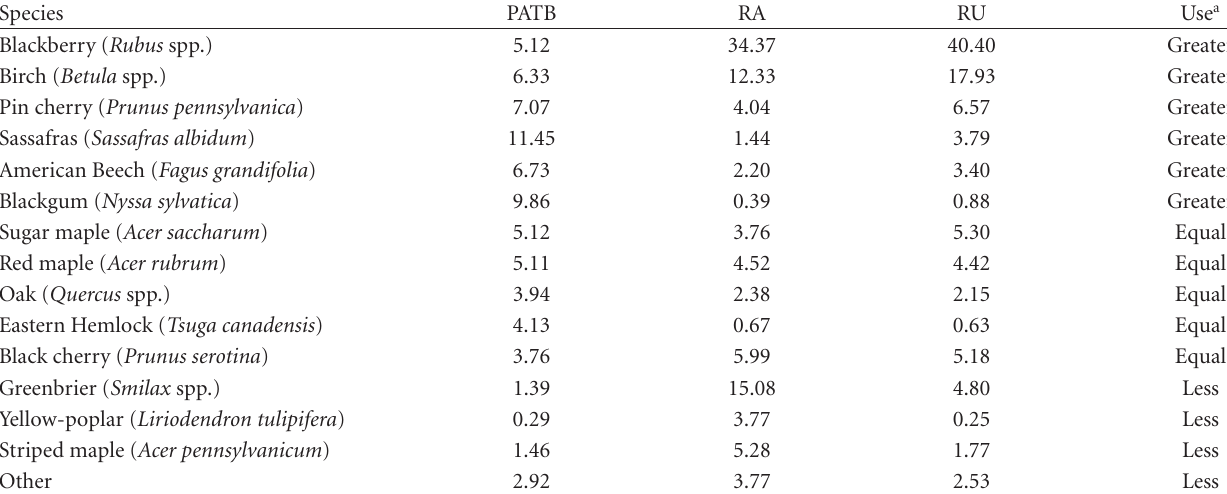
Table 2: Percent of available twigs browsed (PATB), relative abundance (RA), relative use (RU), and white-tailed deer selection for woody Species PATB RA RU Use a Blackberry ( Rubus spp.) Birch ( Betula spp.)